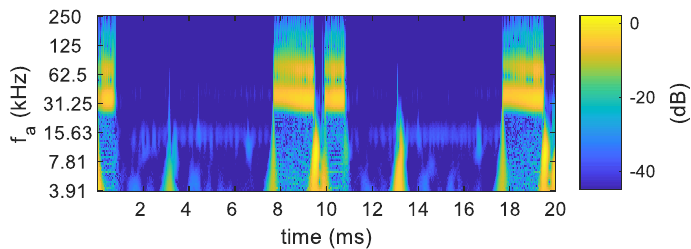
Figure 20. Scalogram of voltage signal during fluorescent lamp (CFL) and pedestal fan operation.